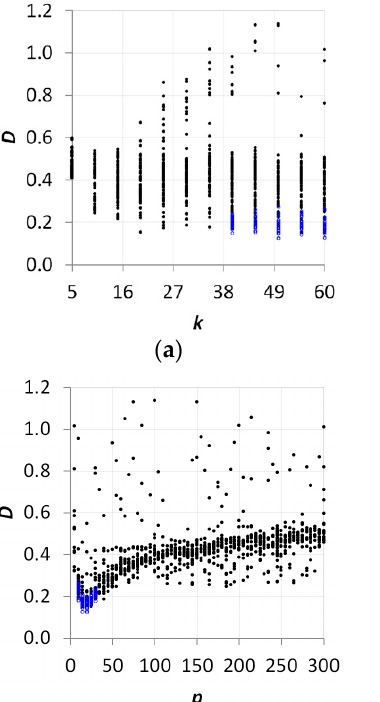
11 of 23 Table 1. Segmentation parameters, images acquired in arid and temperate periods. k ( d ) Figure 7. Segmentation parameters optimized on perimeters for the arid period: ( a ) D versus k ; ( b )